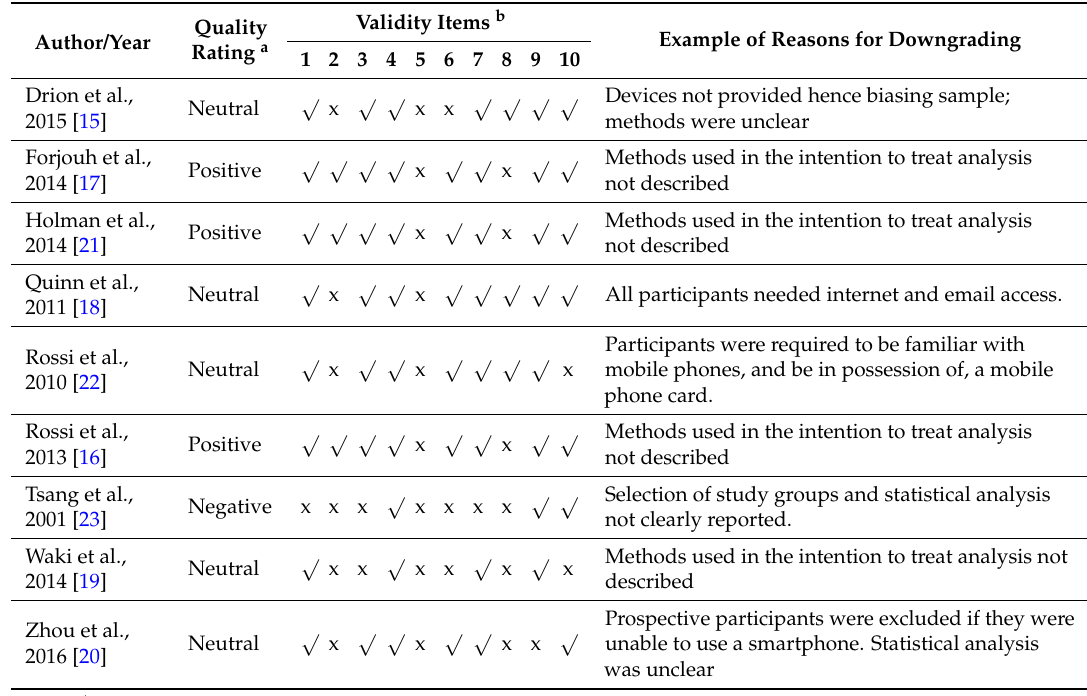
Table 2. Quality assessment of studies comparing the effect of using mobile devices to record food or nutrition intake to usual care on diabetes control and nutrition